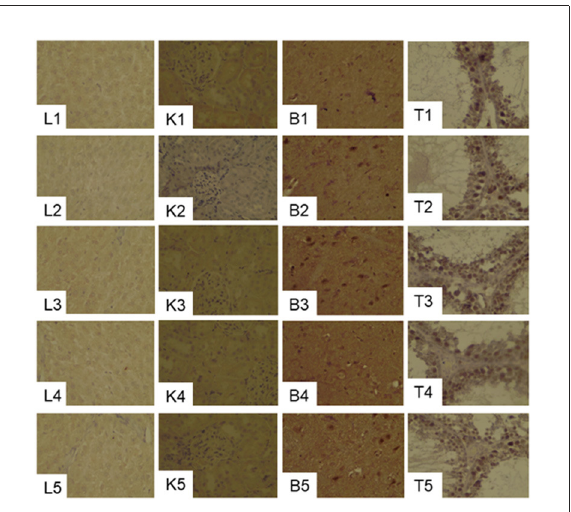
FIGURE4 Effects of supplementation of serine-deprived diet with serine (0.5, 1.0, and 2.0 times the amount of serine in 20C) on the expression of GPx1in the liver (L1–L5), kidney (K1–K5), brain (B1–B5) and Testis (T1–T5) tissues in rats fed 20C (experiment 1). See the legend of Figure 3 for other